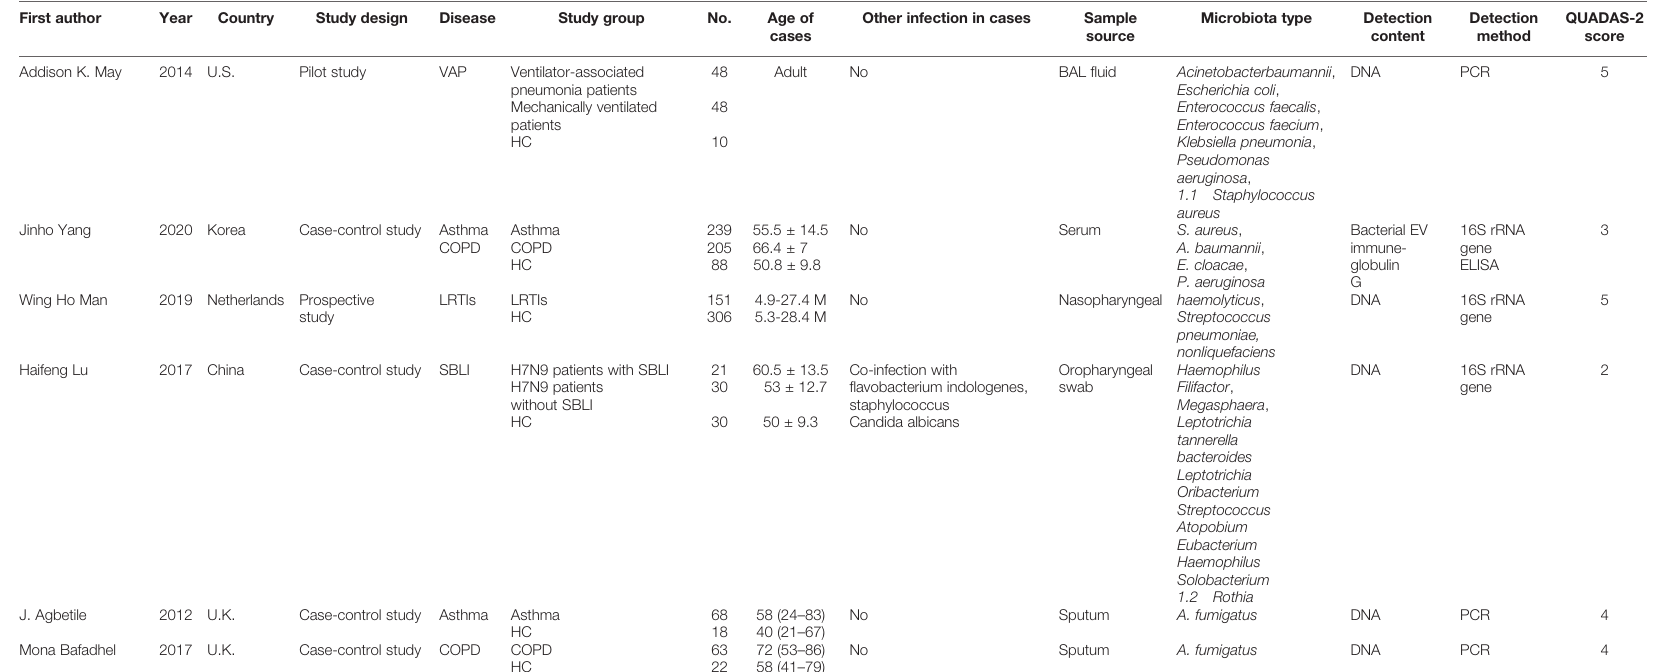
TABLE 1 | Characteristics of the included